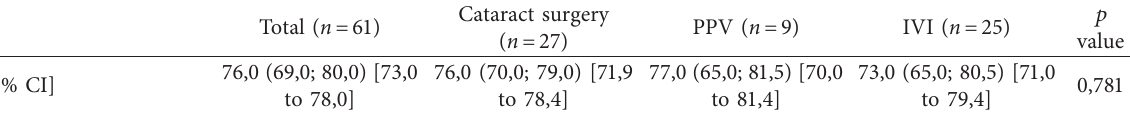
Table 1: Patient characteristic data of presumed endophthalmitis cases ( n � 61) after cataract surgery, intravitreal injections (IVI), and pars